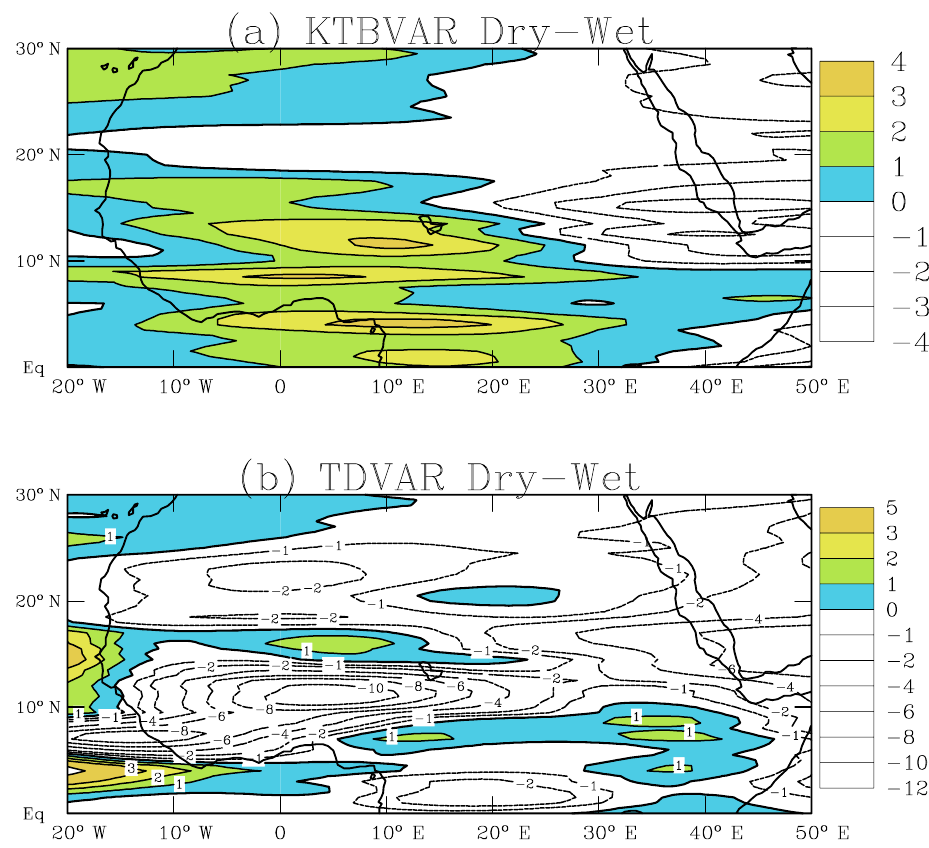
Figure 5. ( a ) KW variance difference between dry and wet years (dry – wet years), ( b ) AEW variance (measured by TD filtered T B variance) difference between dry and wet years (dry – wet years). Variances are in K 2 . Positive differences are shaded.